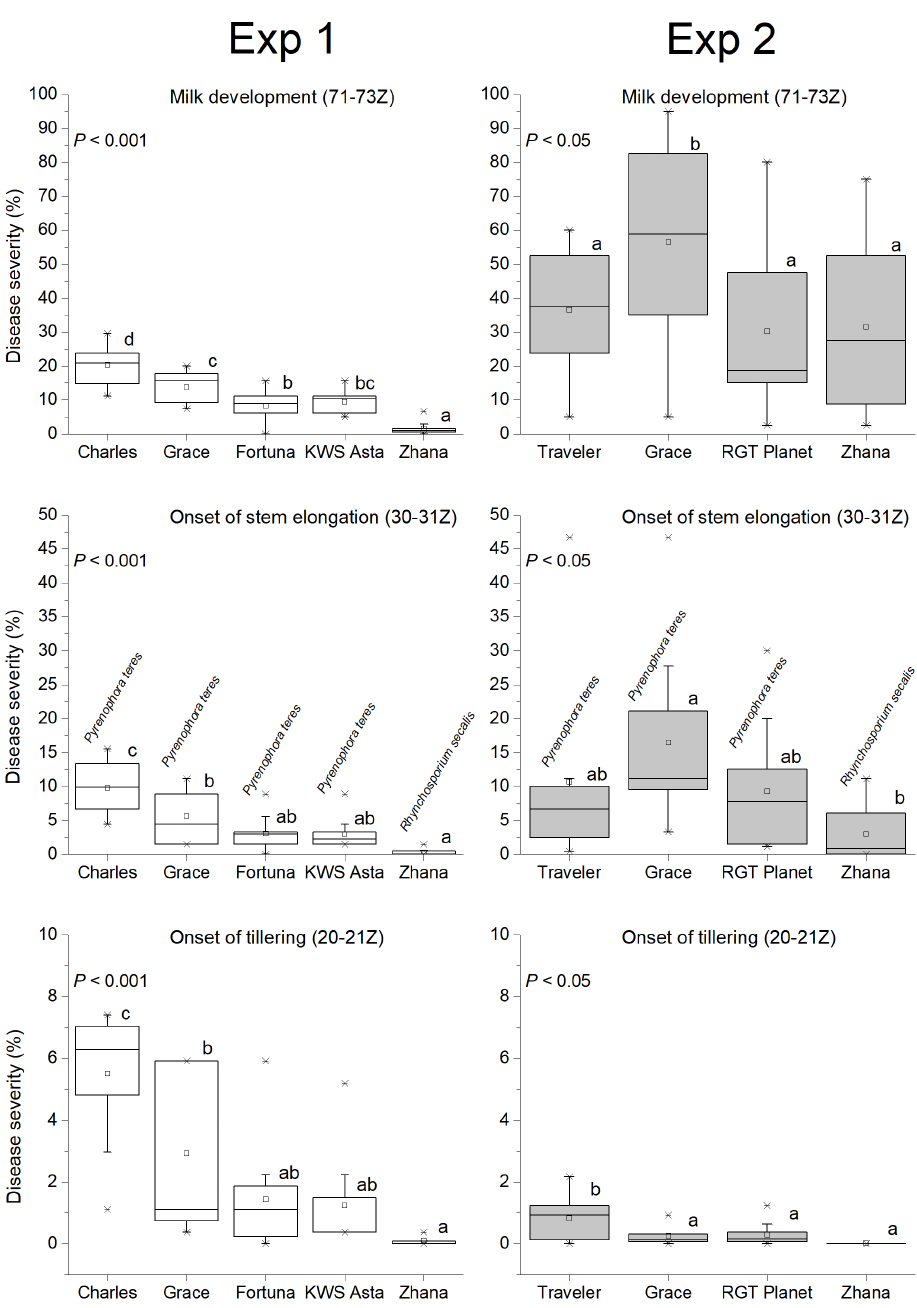
Figure 3. Malt barley cultivars’ susceptibility to Pyrenophora teres f. teres (net form net blotch—NFNB) and Rhynchosporium secalis (leaf blotch and scald) at different developmental phases during both experiments. The numbers in the brackets refer to the Zadoks scale. Broad lines are medians, square open dots are means, boxes show the interquartile ranges, and whiskers extend to the last data points within 1.5 times the interquartile ranges. p -values of ANOVA and permutation tests are given. Groups not sharing the same letter are significantly different according to least significant difference (LSD) test ( p < 0.05).